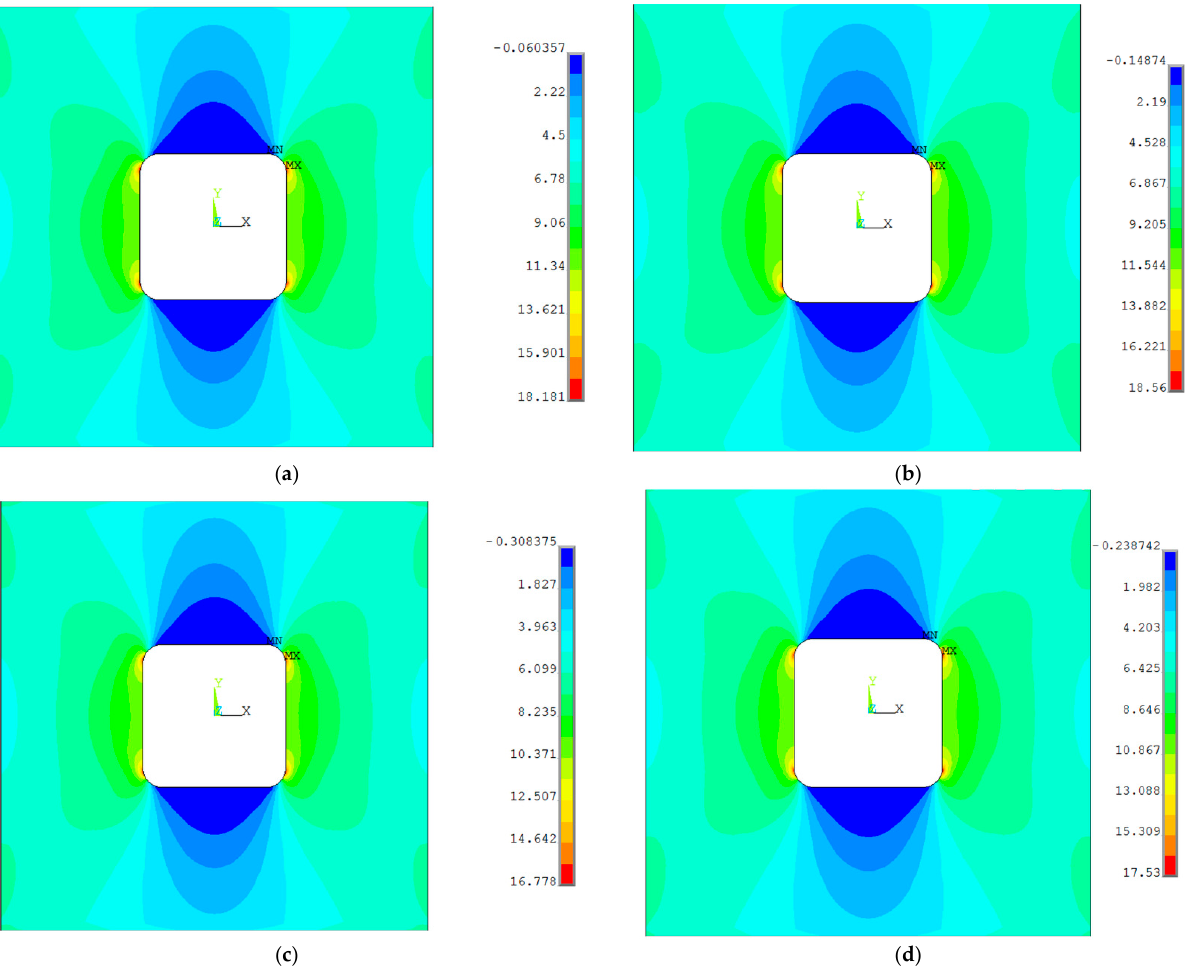
Figure 29. Distribution of tension stress σ y for square patch in steel part (45 × 45) under patch: for different fiber angle orientation: ( a ) θ = ±45°; ( b ) θ = 90°; ( c ) θ = 0°; ( d ) θ = 0°/90°.